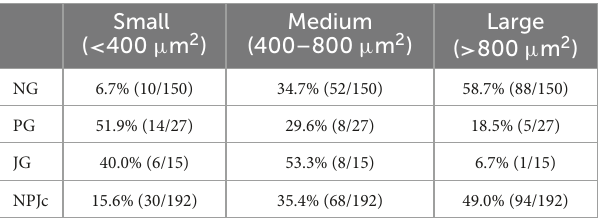
TABLE 1 Cell size distribution of FG-stained TRPV4 immunoreactive neurons in the